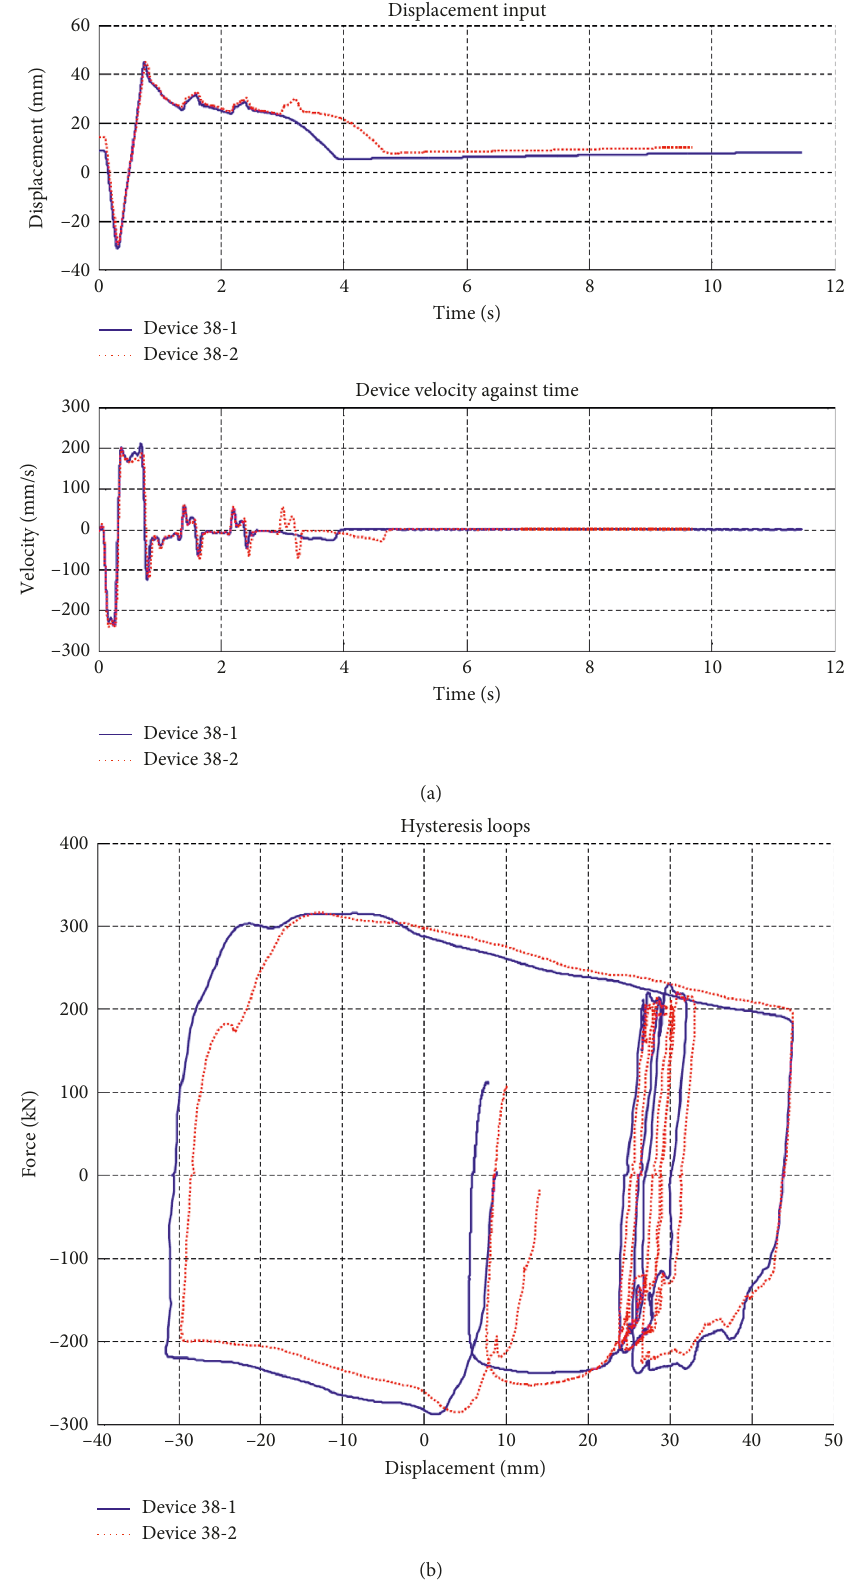
Figure 8: Representative results showing 3 fully reversed cycles at 200.0mm/s device velocity command (but not achieved) with inputs of displacement and velocity (a) and resulting hysteresis loops